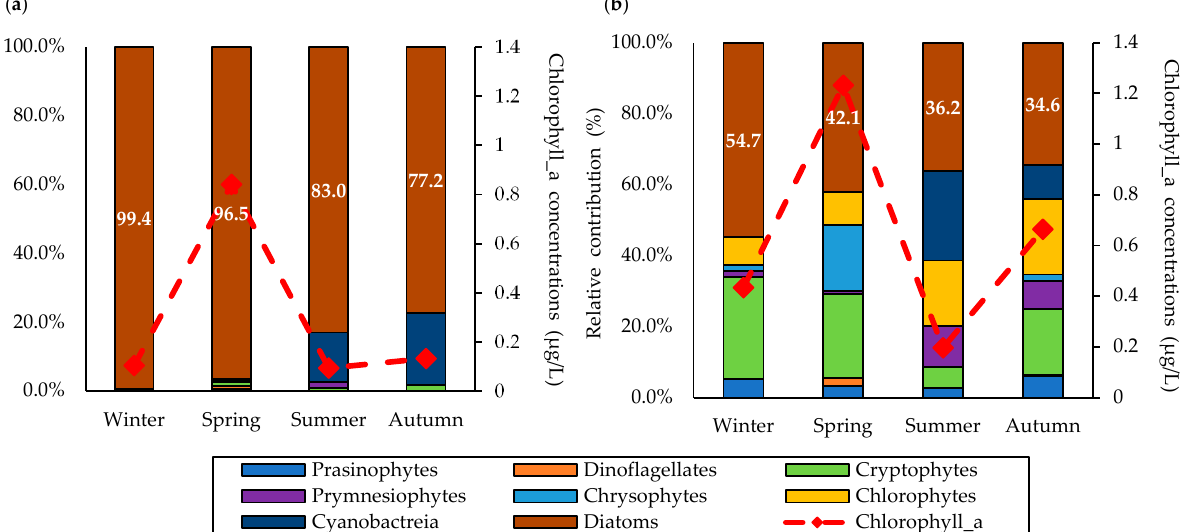
Figure 5. Relative contributions of the size-fractionated phytoplankton community in the YS during the study period in 2019: ( a ) large-sized group; and ( b ) small-sized group.